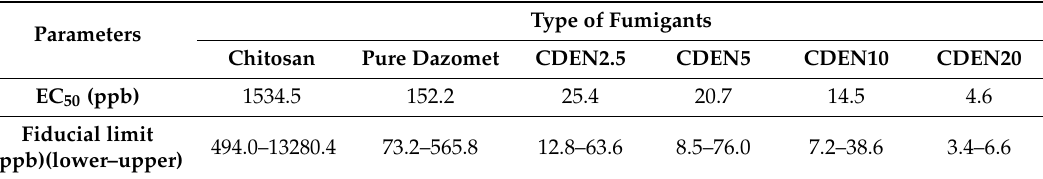
Calculated half maximum e ff ective concentration (EC 50 ) of chitosan, pure dazomet, and chitosan-dazomet nanoparticles prepared at various concentrations of TPP on G. boninense at day 7 of incubation at 28 ± 2 ◦ C.